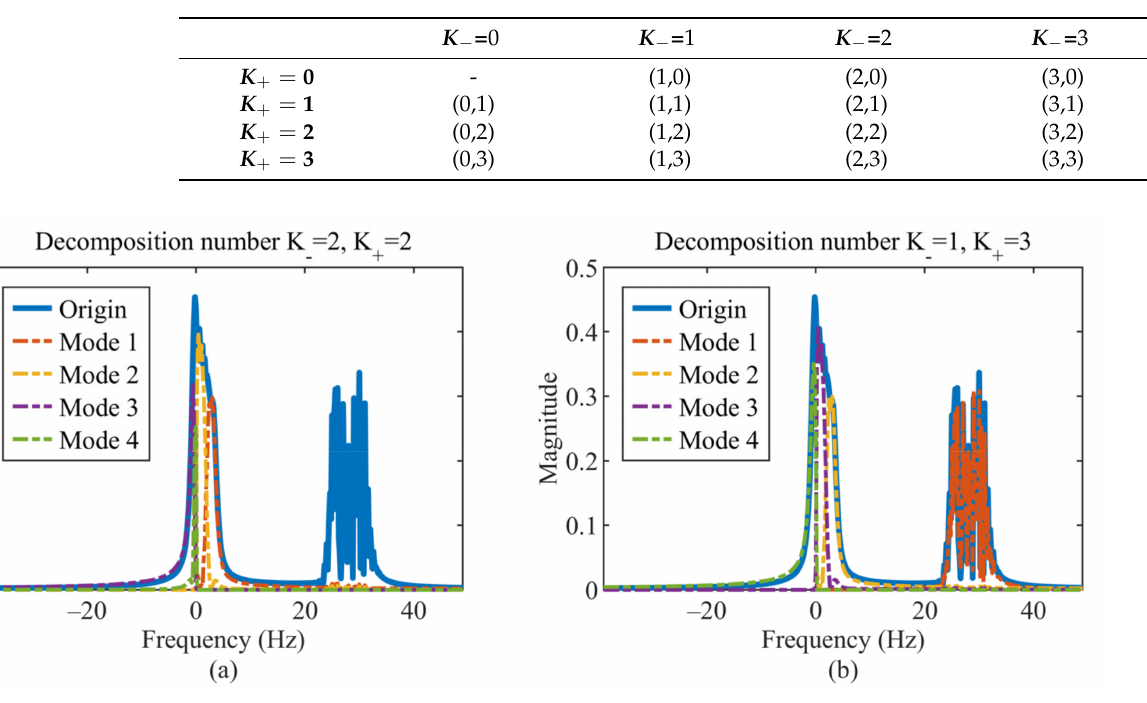
Figure 9. Spectrum of the original signal (blue solid line) and the decomposition modes (dotted line): ( a ) decomposition number K − = 2 and K + = 2, and ( b ) decomposition number K − = 1 and K + =